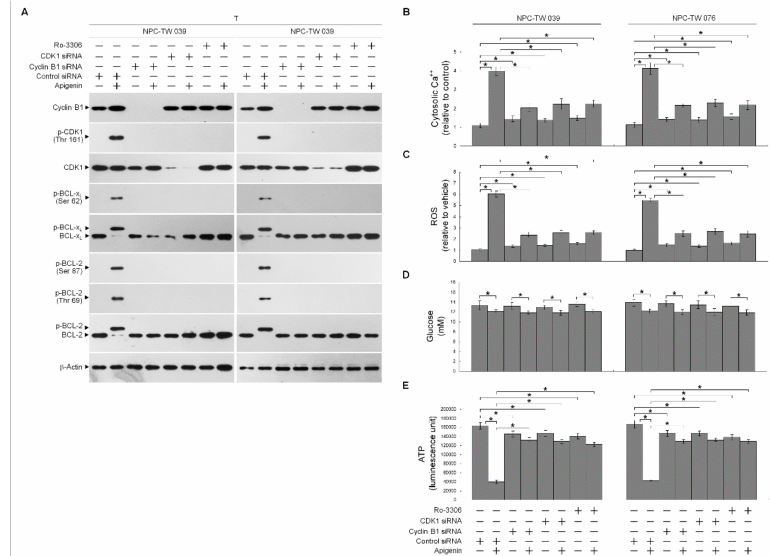
Figure 4. Apigenin-induced phospho (p)-cyclin dependent kinase 1 (CDK1) (Thr 161)–cyclin B1 activity involved in dysregulation of the endoplasmic reticulum (ER)/mitochondria bioenergetic metabolism. ( A – E ) At 12 h after transfection with control small interfering RNA (siRNA), cyclin B1 siRNA, or CDK1 siRNA, NPC cells were treated with vehicle (-), apigenin (35 µ M), Ro-3306 (3 µ M), or apigenin (35 µ M), and Ro-3306 (3 µ M) for 36 h. The levels of the indicated proteins in the whole cell lysates of transfected cells were determined by Western blot analysis with specific antibodies. The levels of cytosolic calcium (Ca ++ ) and reactive oxygen species (ROS) were determined by measuring the increased fluorescence of Indo-1 and 2,7-dichlorodihydrofluorescein by flow cytometry. The values of glucose and adenosine triphosphate (ATP) were analyzed using glucose assay and ATP-based CellTiter-Glo Luminescent Cell Viability kits, respectively. The values are presented as the means ± standard error of three independent experiments. * p < 0.05: significantly different from vehicle- or apigenin-treated cells.